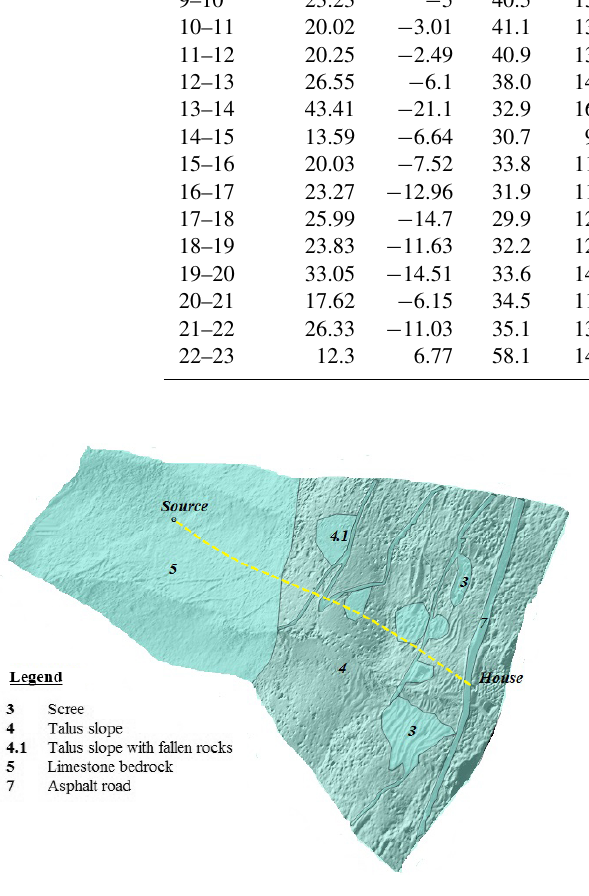
Figure 13. Soil types for 3-D rockfall analysis (according to Rocky- for3D). The yellow line showing the path of the trajectory is